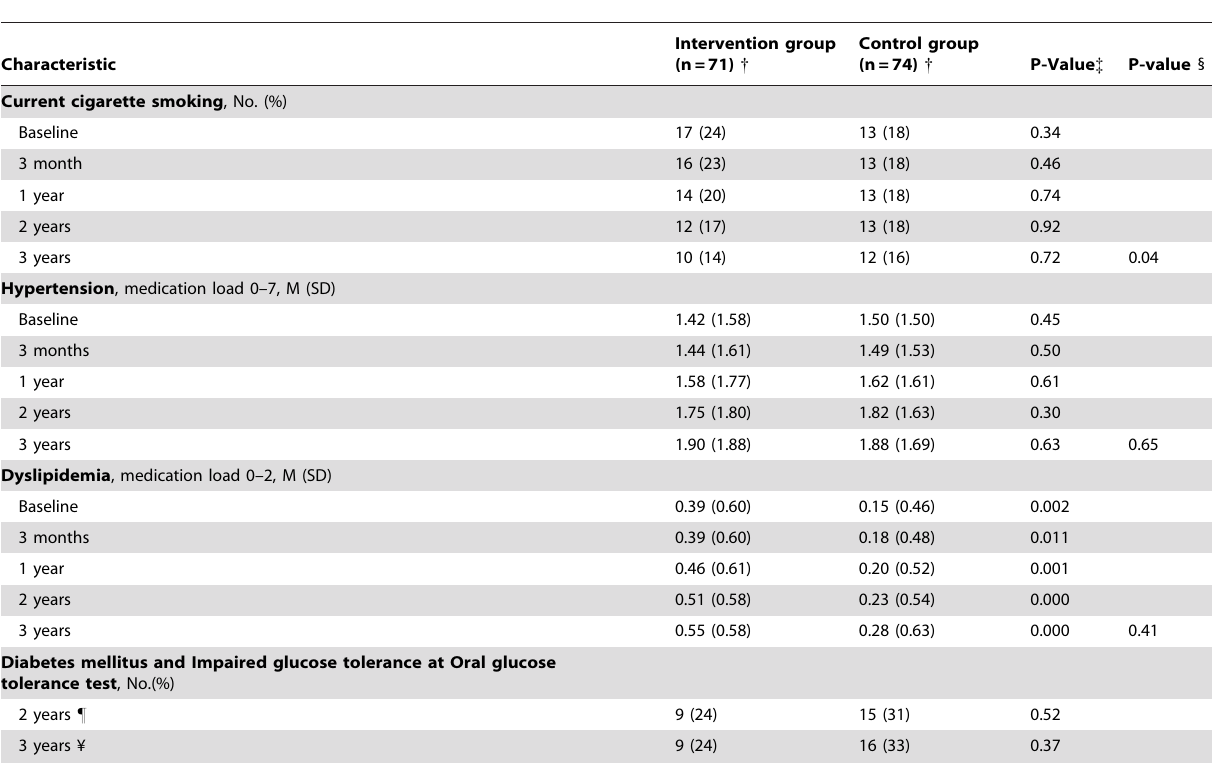
Table 3. Changes in medication treatment and cigarette smoking from baseline to 3 years follow-up in the Swedish Bjo¨rkna¨s